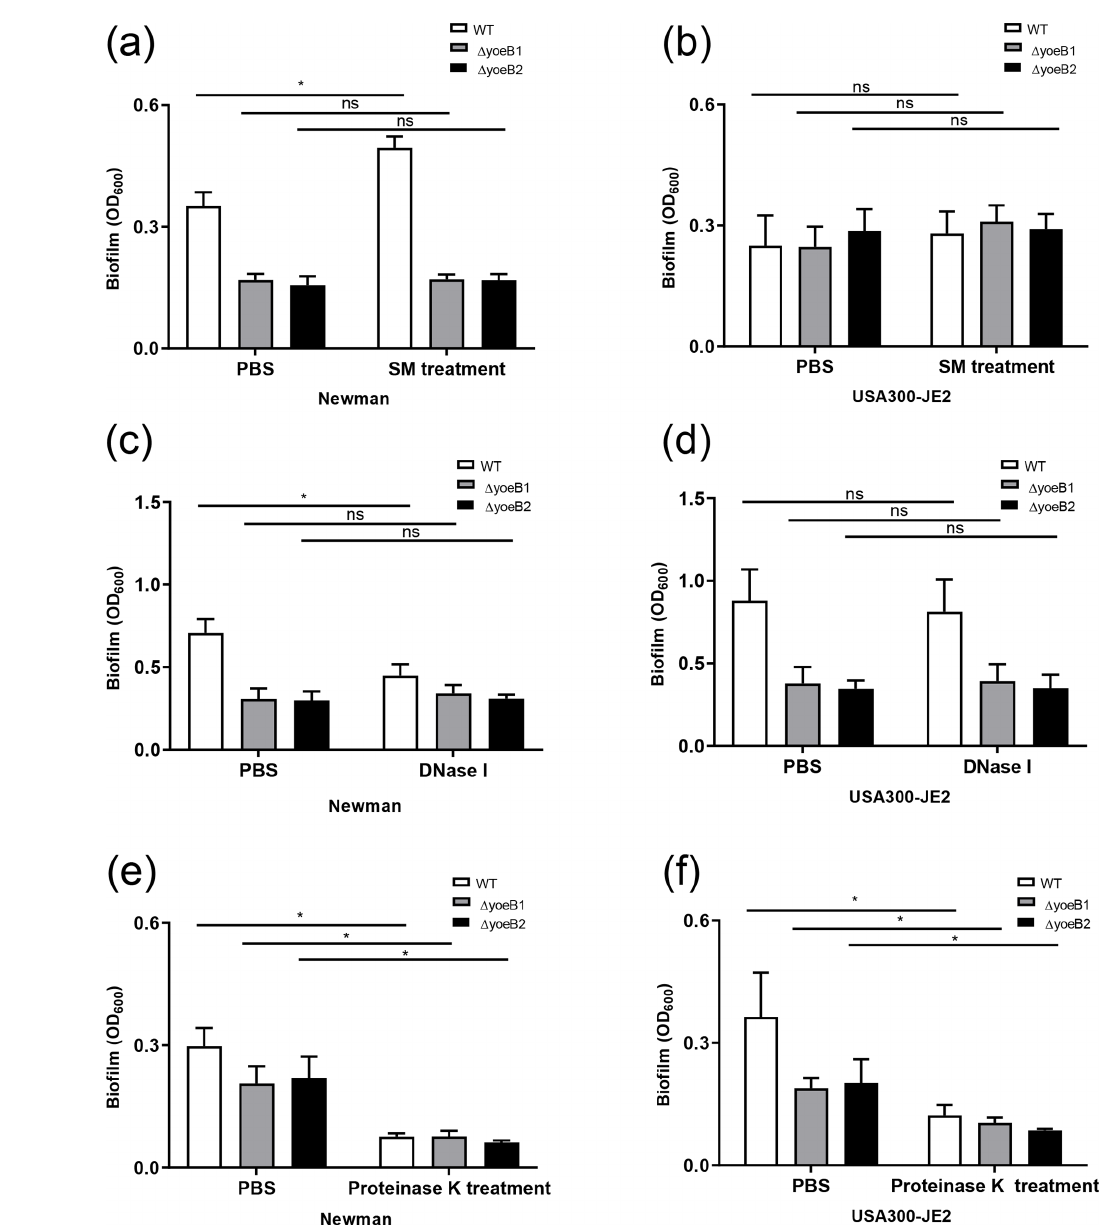
Figure 3. YoeB is associated with extracellular polymeric substance (EPS) biofilm formation. In the (a) Newman strain, sodium metape- riodate (SM) treatment of yoeB mutants has no effect on biofilm formation but increases biofilm in WT. No differences were observed in (b) USA300-JE2. After DNase I treatment (c) , Newman WT demonstrates a reduction in biofilm. However, no changes were observed in yoeB mutants. No differences in biofilm were observed in (d) USA300-JE2. Reductions in biofilm formation were observed after proteinase K treatment for (e) Newman and (f) USA300-JE2 (ns: not significant, * p < 0 .